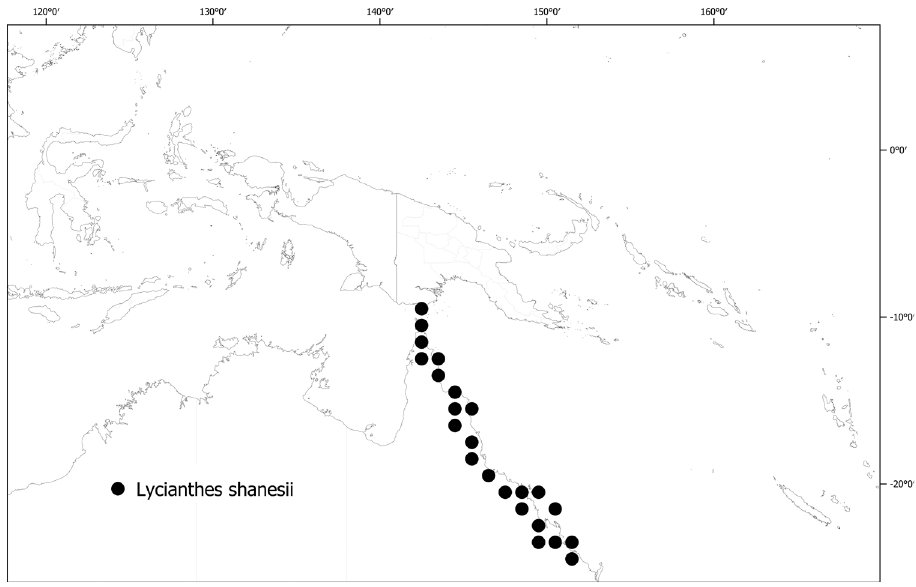
Figure 50. Distribution of Lycianthes